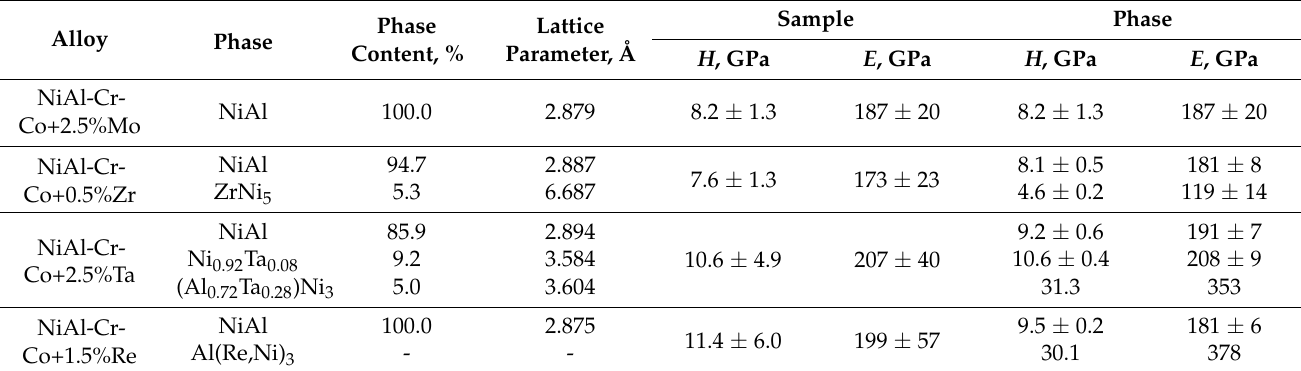
Table 5. The phase composition and mechanical properties of the cast NiAl–Cr–Co–( X ) alloys and individual phases. Alloy